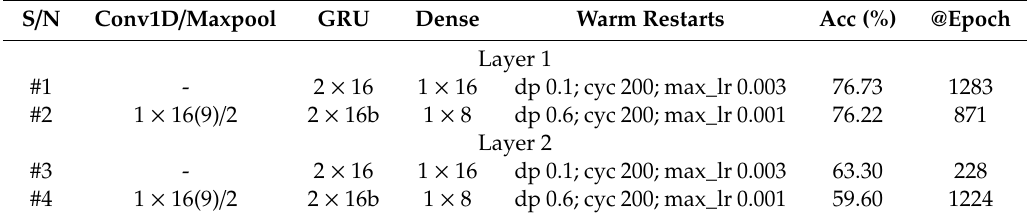
Table 4. Training (with warm restarts) validation